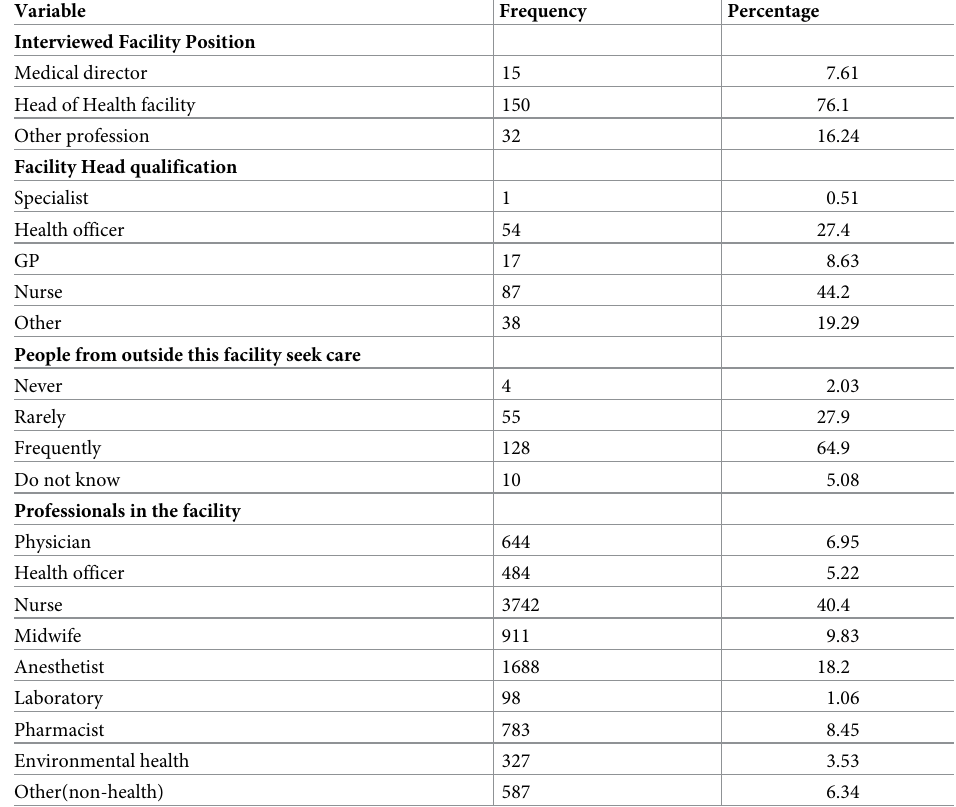
Table 3. Health facility characteristics of the study area in Amhara regional state, Ethiopia, 2016.